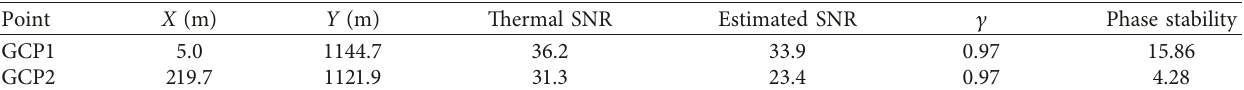
Figure 13: Nonenvironmentally corrected amounts of deformation (the shade of color represents the magnitude and direction of the displacement). Table 2: Information on the environmental correction control